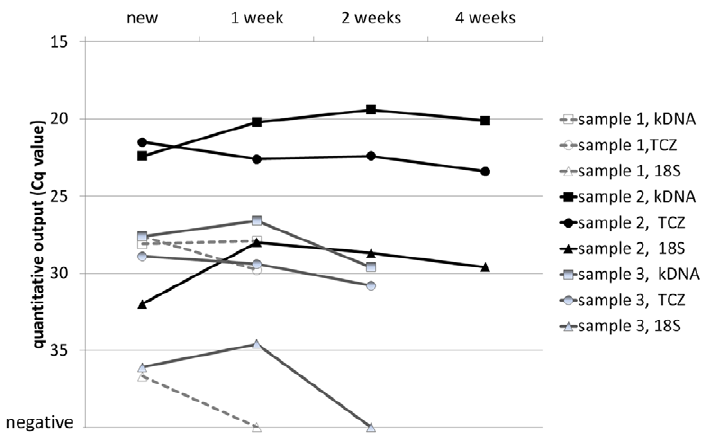
Figure 1. Effect of storage of EDTA blood specimens on real-time PCR results. The lower the Cq (quantitative cycle) value, the better recovery was obtained from the DNA extraction